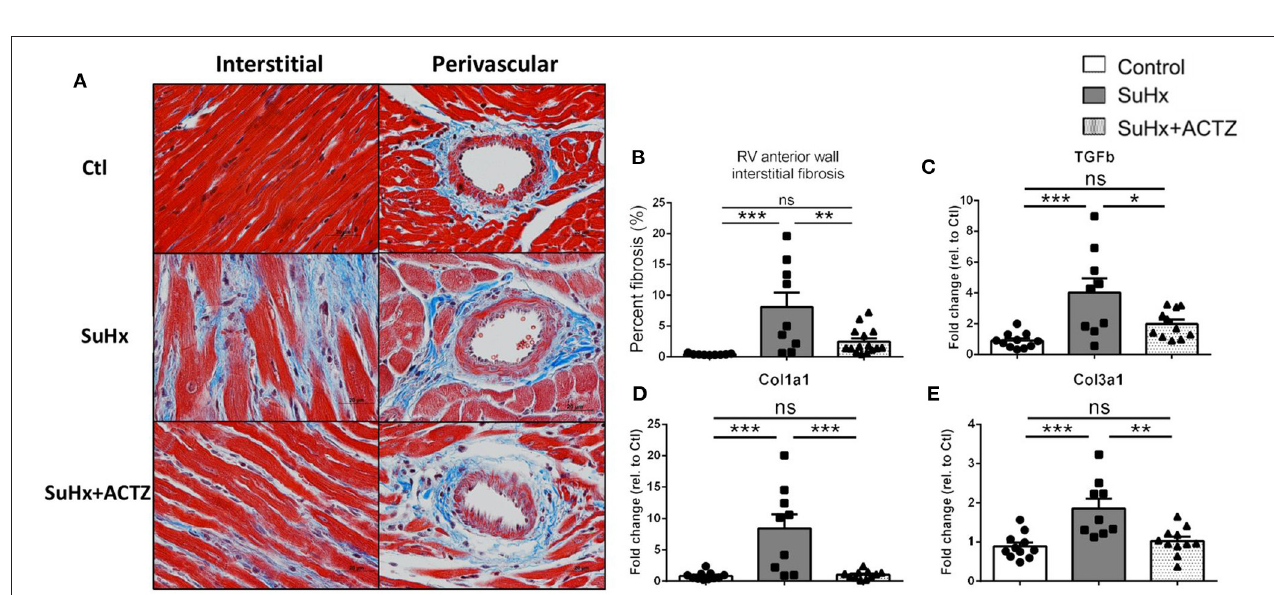
FIGURE 6 | Amelioration of interstitial cardiac fibrosis in the right ventricle of Sugen 5416/hypoxia (SuHx) animals treated with acetazolamide (ACTZ). (A) Representative cardiac tissue sections stained with Masson’s trichrome stain to detect interstitial and perivascular fibrosis. Scale bar 20 µ m. (B) Quantitative analysis of interstitial fibrosis in the RV in the three experimental groups ( n = 6–9 animals per group). Real-time PCR analysis of the fibrosis associated transcripts (C–E) transforming growth factor- β 1( Tgfb1 ), collagen α -1(I) chain ( Col1a1 ), collagen α -1(III) chain ( Col3a1 ) ( n = 10–12 per group). Experimental groups: Control, SuHx, and SuHx + ACTZ. Statistical analysis by one-way ANOVA and Tukey’s post-hoc test. Error bars are mean ± SEM (* P < 0.05, ** P < 0.01, and *** P < 0.001; ns, nonsignificant).